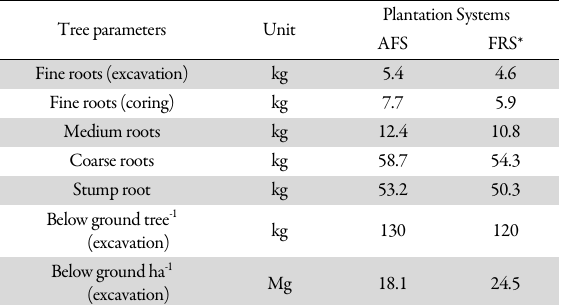
Table 1. Synthesis of the biomass results in Agroforestry (AFS) and Forestry (FRS) Plantations